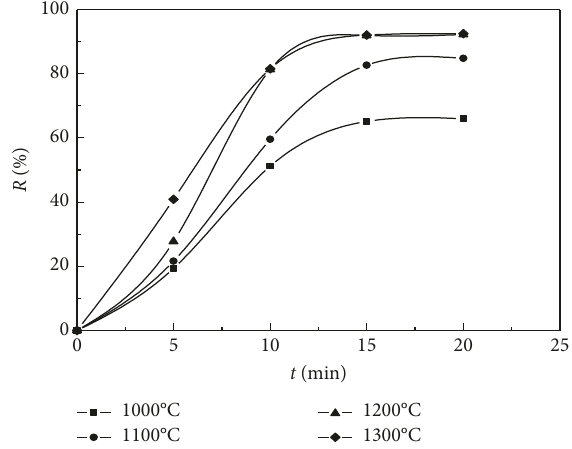
Figure 3: Reduction degree of carbon-containing pellets with C/O ratio of 0.9 at different temperatures.